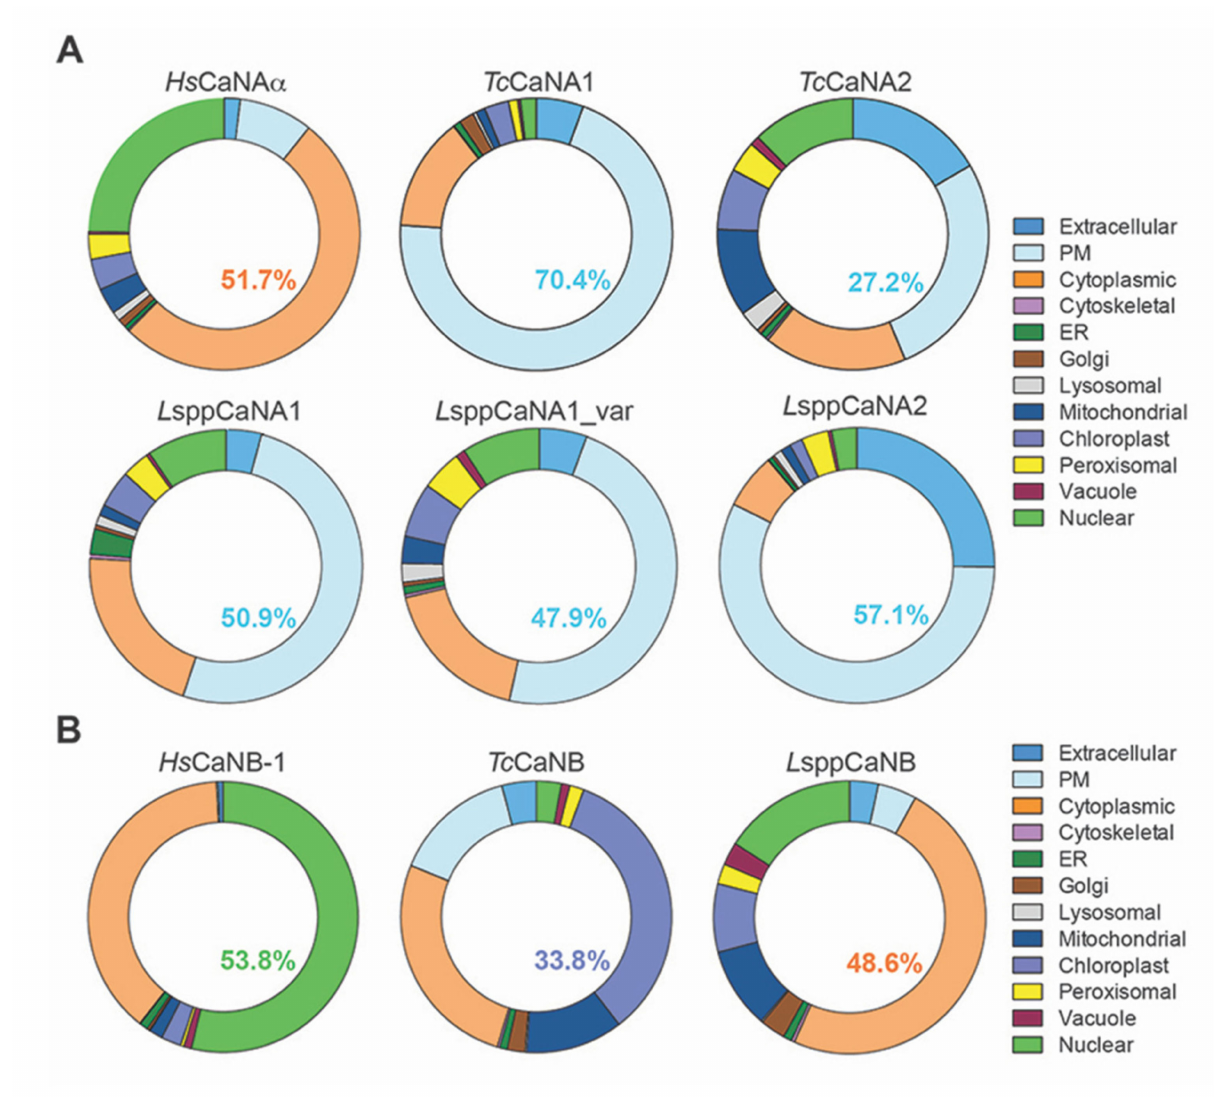
Figure 8. The predicted subcellular localization of CaNA ( A ) and CaNB ( B ) using the CELLO2GO web server. The subcellular localizations are represented in ring chart diagrams evaluating the significant terms in the form of their percentage contribution. In each one, the value with the highest probability is